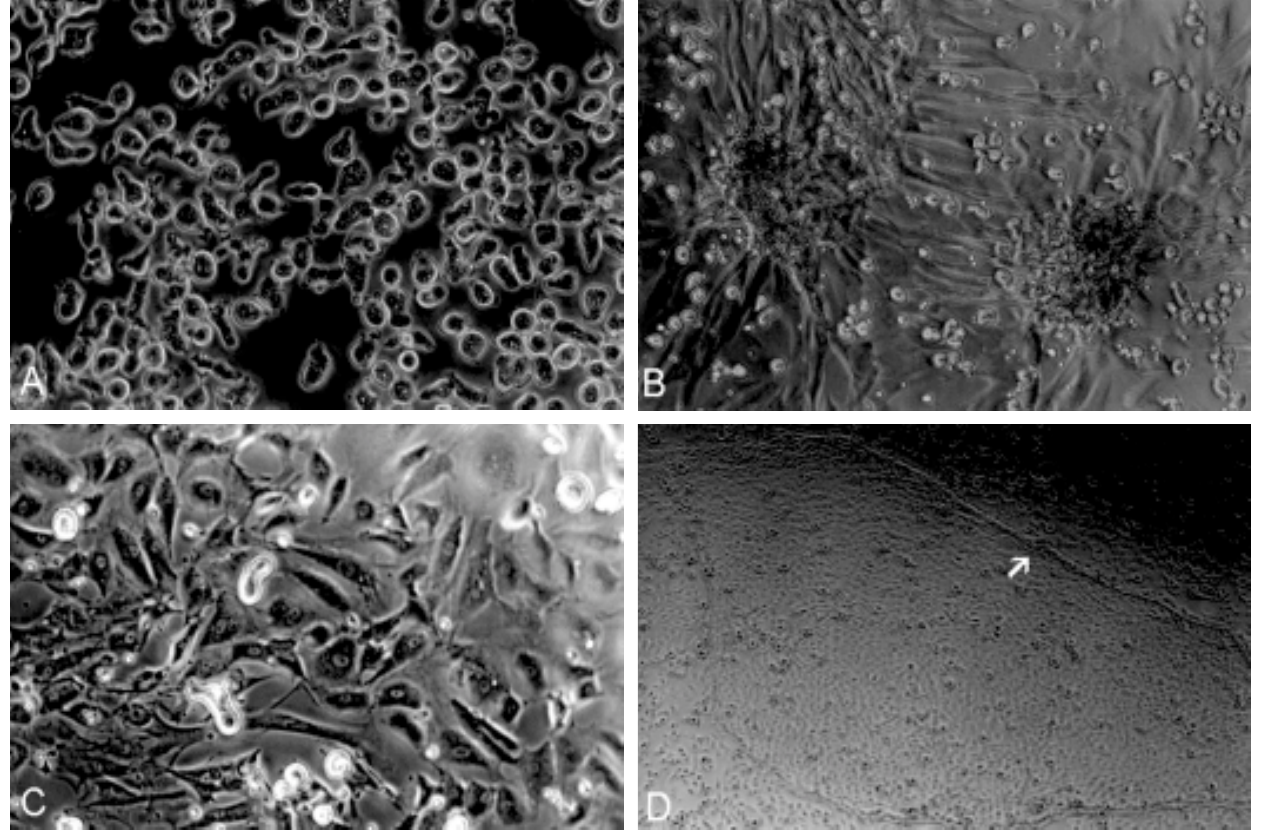
Figure 1 - Morphology of cultured cord blood cells photographed with an inverted microscope. A , Large myeloid cells whose appearance in the first week correlated with the occurrence of negative cultures (200X). B , Bone marrow-type adherent cells, showing mainly fibroblast-like cells (100X). C , Cord blood-type adherent cells, with predominantly endothelial-like cells (200X). D , Cord of cells (arrows) detected in two of the 16 positive cultures